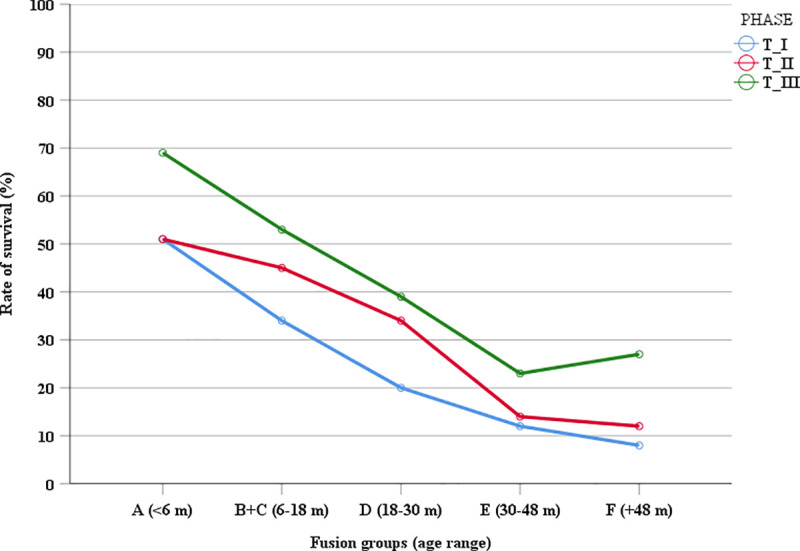
Survivorship curves for Els Trocs caprines in each occupation period.The data computed derives from the fusion groups in Table 2.